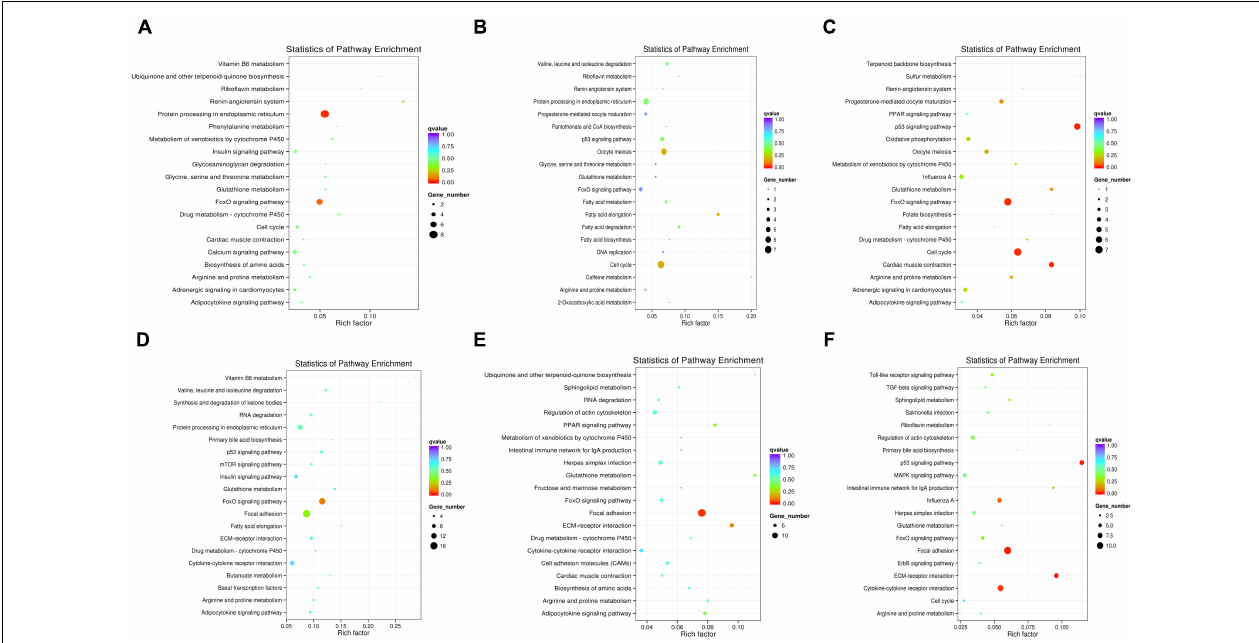
FIGURE 4 | The top 20 KEGG pathways enriched in the six combinations. (A) W14 vs. W6 group. (B) W22 vs. W6 group. (C) W22 vs. W14 group. (D) W30 vs. W6 group. (E) W30 vs. W14 group. (F) W30 vs. W22 group.